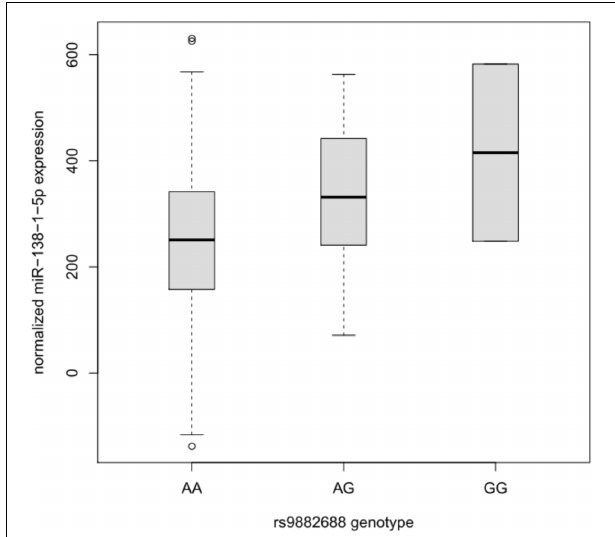
FIGURE 4 | Box plot of the distribution of hsa-miR-138-1-5p expression levels in lymphoblastoid cell lines dependent on the rs9882688 genotype in 308 individuals of European descent. Horizontal lines represent median values, boxes represent interquartile ranges, and whiskers extend to 1.5 × the interquartile range; values outside this range are depicted as circles. Carriers of the rs9882688 G allele showed a statistically significant ( P = 0 . 000504) increase in hsa-miR-138-1-5p expression